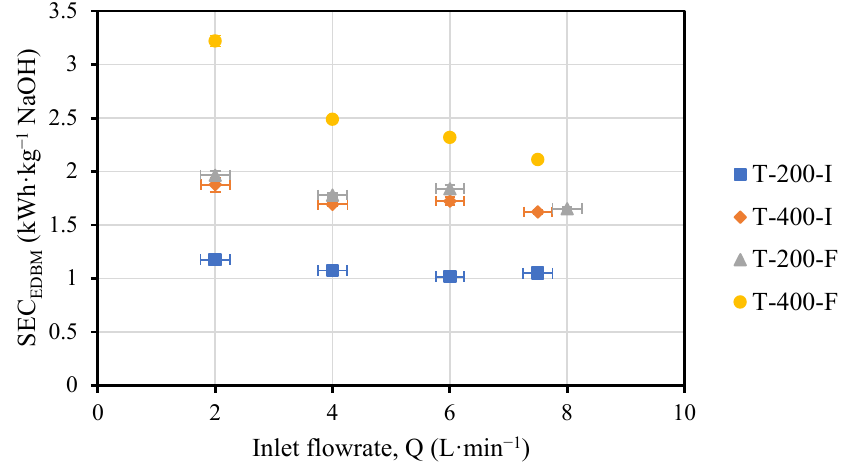
Figure 4. Values of SEC EDBM (kWh ∙ kg ‐ 1 NaOH) versus flowrate: ( a ) T ‐ 200 ‐ I; ( b ) T ‐ 400 ‐ I; ( c ) T ‐ 200 ‐ F; ( d ) T ‐ 400 ‐ F. Vertical error bars have been estimated via error propagation theory and are so low (i.e., <5%) that cannot be visualized in the figure.